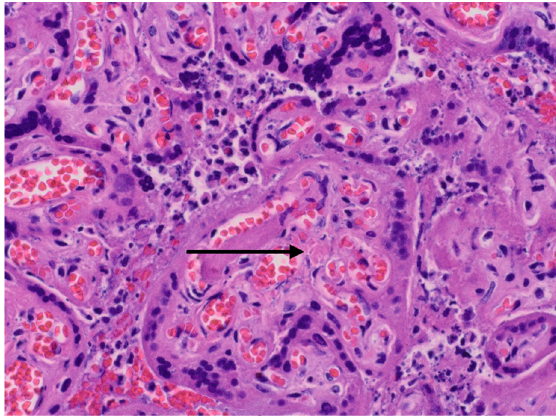
Figure 2. Histopatological images. Arrow—small infarcts.